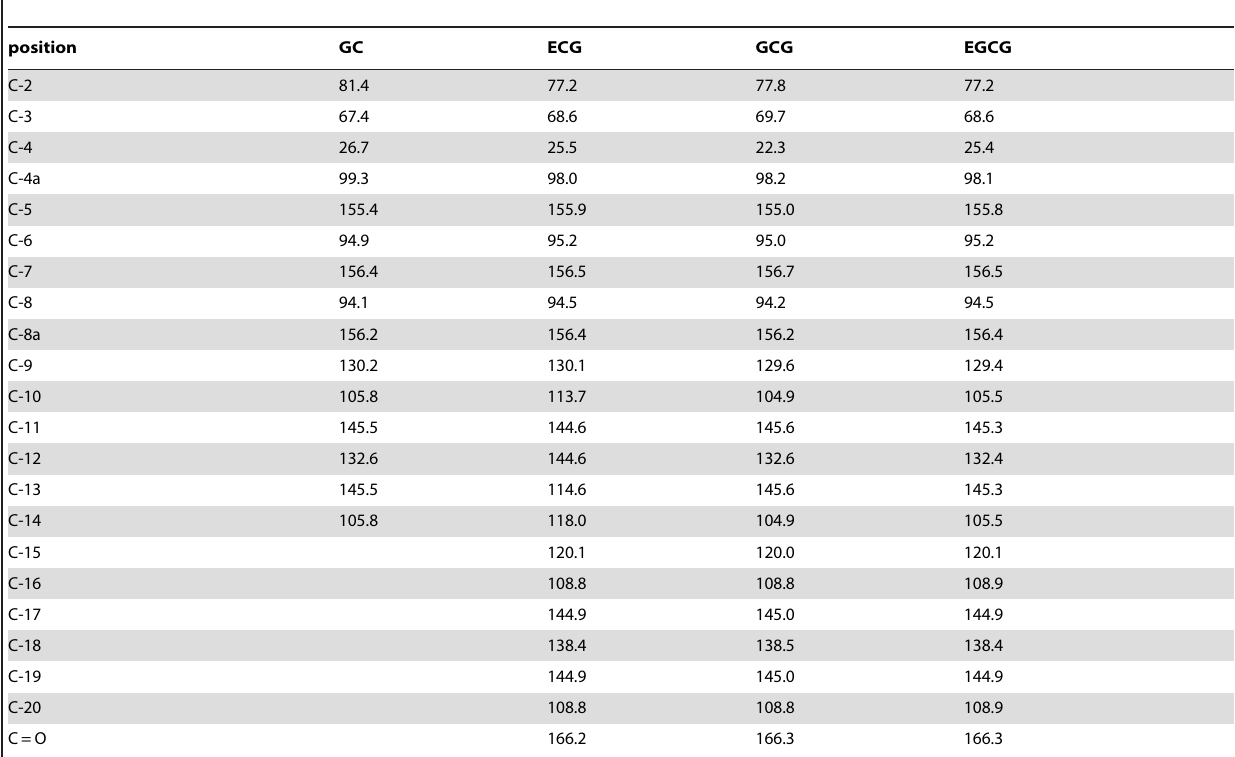
Table 1. 13 C (600 MHz) NMR Data of GC, ECG, GCG, EGCG in